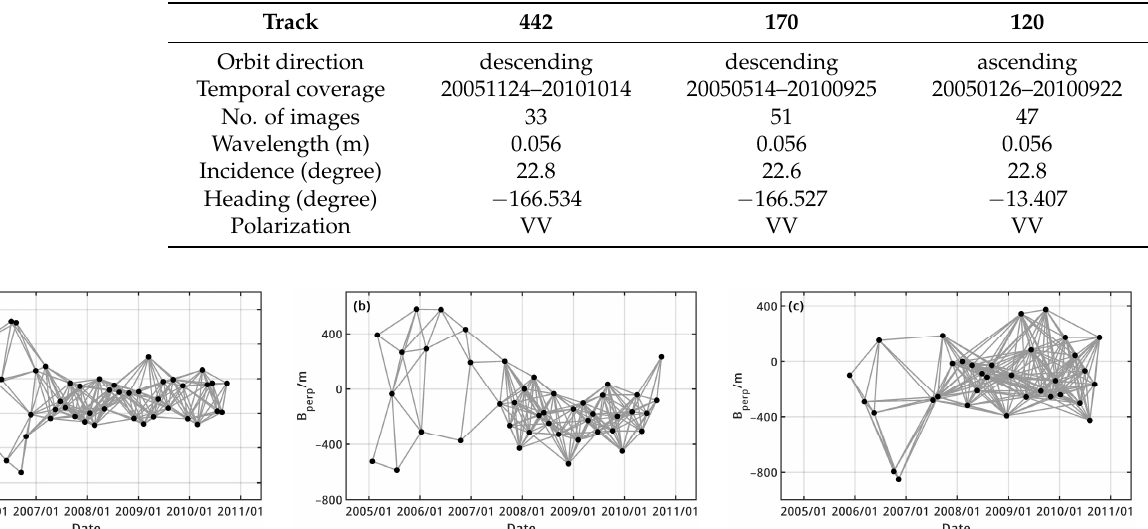
Figure 1. Illustration of temporal–spatial baseline distribution. ( a ) track 170; ( b ) track 120; ( c ) track 442.